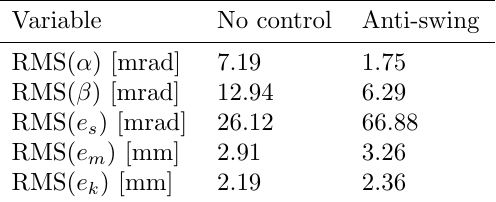
Table 8: Quantitative laboratory